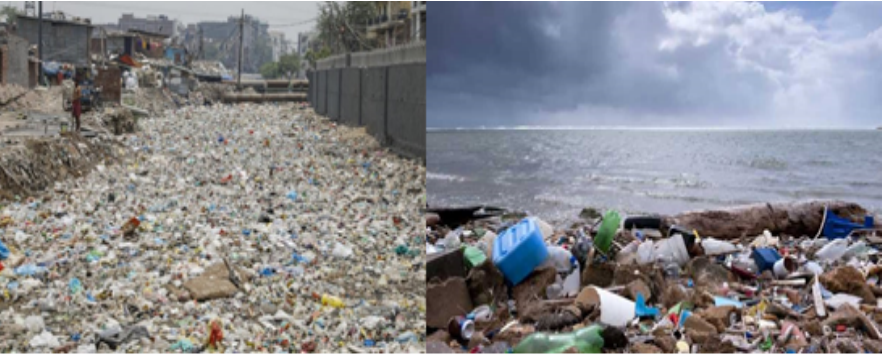
Figure 1. Waste plastic on land and